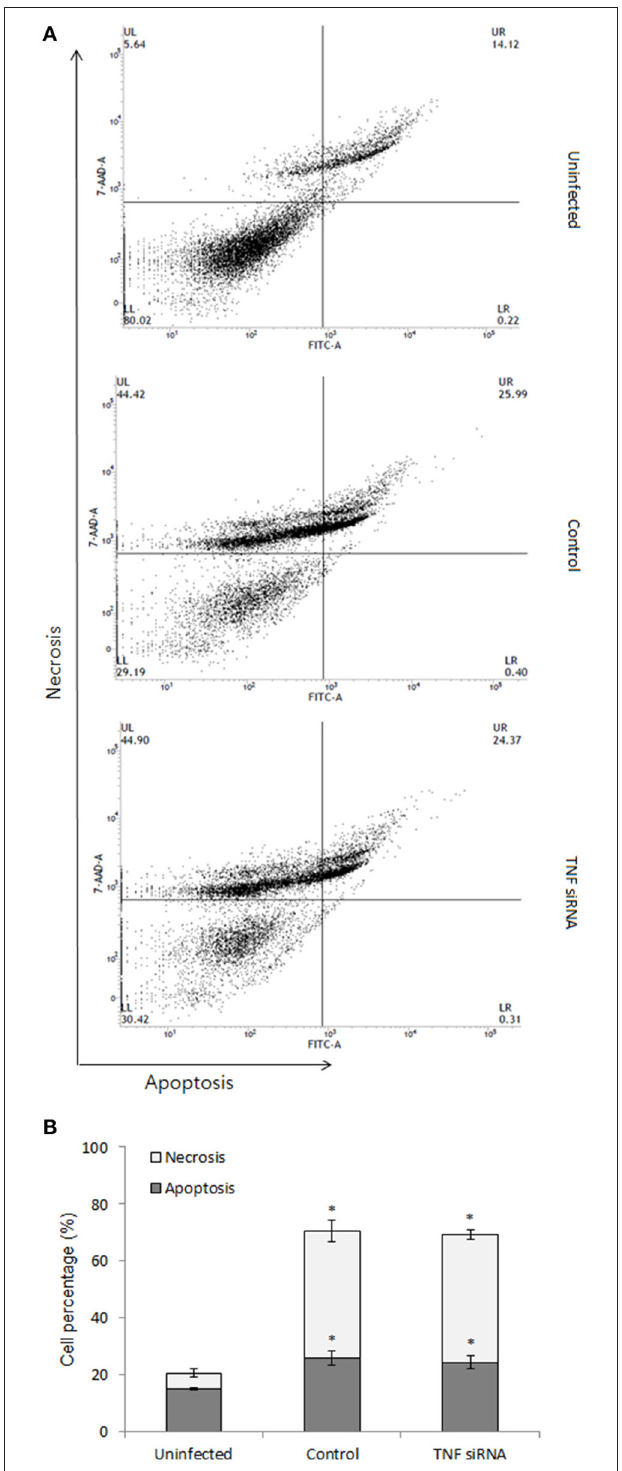
FIGURE 5 | Cell death assay was carried out at 48h pi. The infected cells were stained with apoptosis indicator (apopxin green) and necrosis indicator (7-AAD) and subjected to analysis by flow cytometry (A) . The percentage of apoptotic and necrotic cells were presented (B) . Data represent the mean ± SD of triplicate experiments. An asterisk indicates a significant difference ( P <